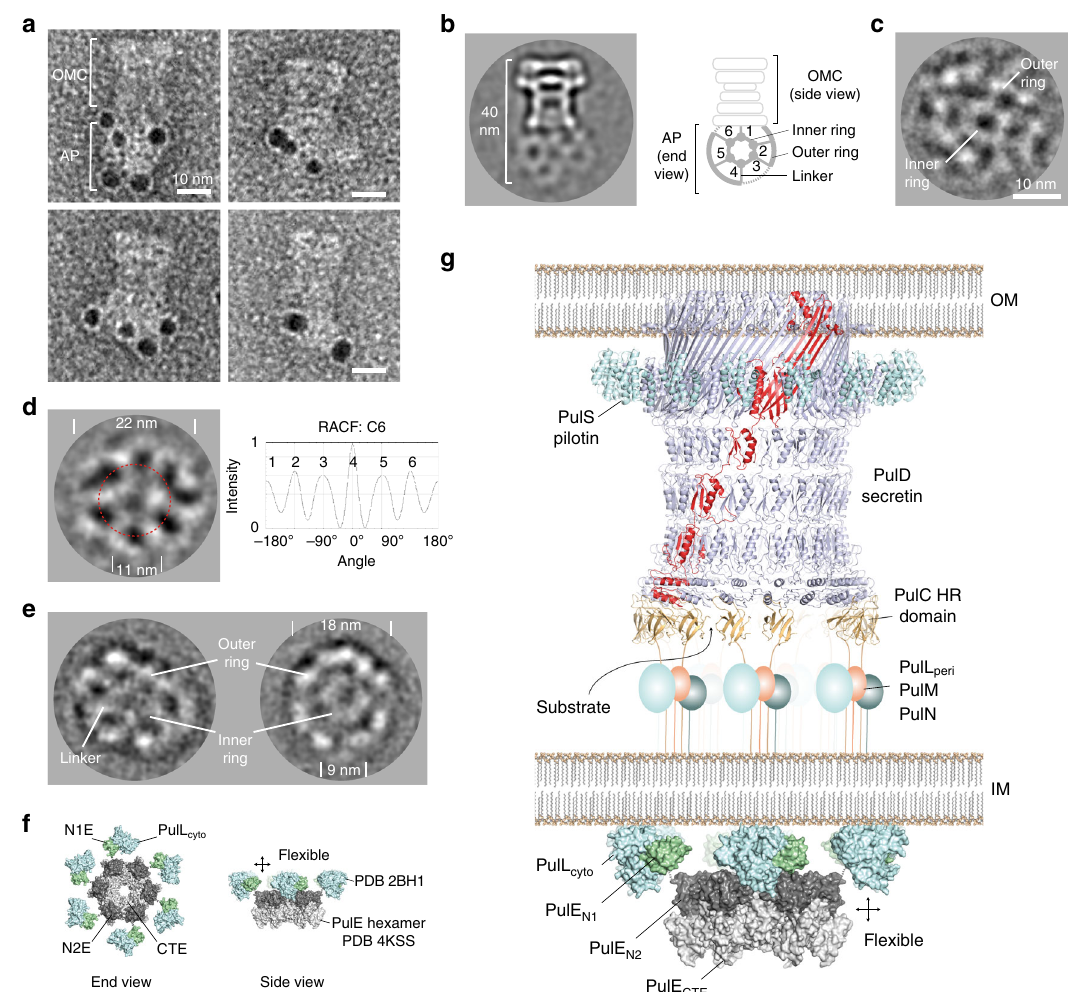
Fig. 6 2D EM of the assembly platform (AP) and a T2SS core model. a Ni-NTA gold bead labelling of the PulC N-terminus. Beads locate exclusively to the AP. b Cryo-EM 2D class average of Pul CDELMNS . The AP showed end views as a preferred orientation with C6 symmetry. c Cryo-EM 2D class average of Pul CDELMNS with the alignment and classi fi cation focused on the AP. d Cryo-EM 2D class average of Pul ELM showing C6 symmetry. RACF rotation auto- correlation function calculated around dotted red radial ring. e Negative stain EM 2D class average of Pul ELM . f Schematic showing modelled arrangement of the Pul EL cytoplasmic domains within the Pul CDELMNS and Pul ELM hexameric hub. The central PulE hexamer (inner ring, PDB 4KSS) is decorated by six copies of the Pul E-N1E/Lcyto complex (outer ring, PDB 2BH1). Connection between inner and outer ring is mediated by the 44 aa fl exible N1E-N2E inter- domain linker. g Stoichiometric model of an assembled T2SS core apparatus. AP components comprise a hexameric hub. PulC connects the AP to the OMC by binding to the secretin base. Substrate may be loaded through the PulC cage in positions where GspC is